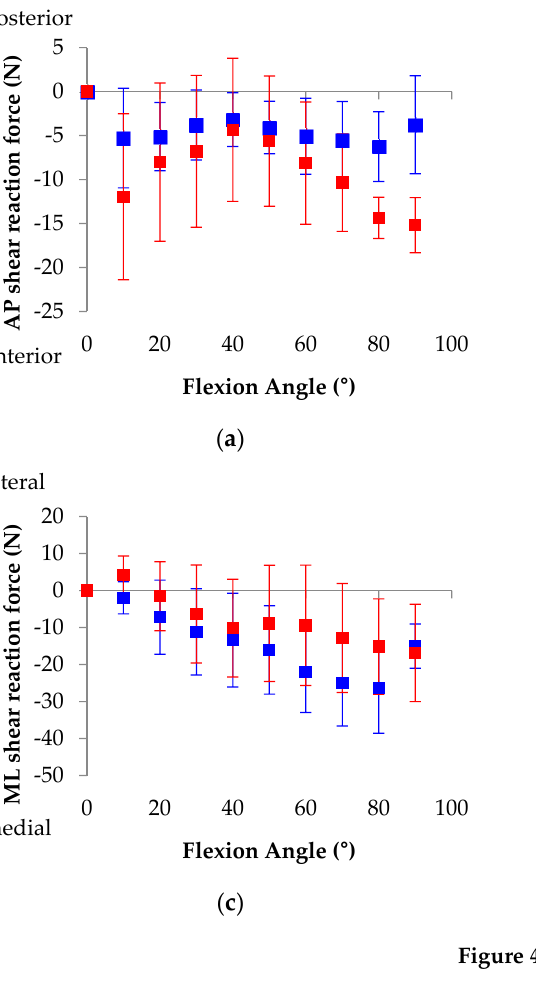
Figure 3. Knee–joint reaction forces and moments in native knee joints with/without VM impairment during knee–joint flexion: ( a ) anterior–posterior reaction force (Fx); ( b ) varus–valgus moment (Tx); ( c ) medial–lateral reaction force (Fy); ( d ) flexion–extension moment (Ty); ( e ) proximal–distal reaction force (Fz); ( f ) internal–external moment (Tz). * p < 0.05.